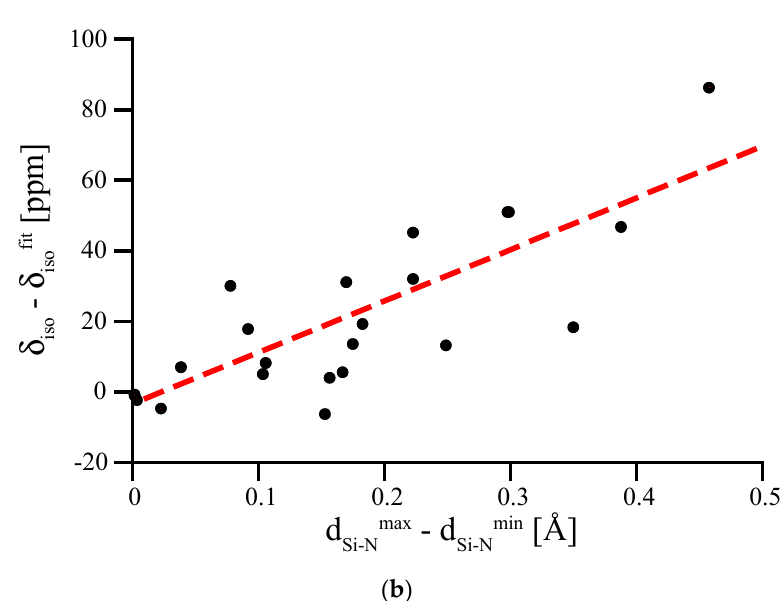
Figure 5. ( a ) 29 Si δ iso of Si [6] sites in hypothetical crystalline Si 3 N 4 plotted versus average Si-N bond length. The inserted line represents data for the Si [6] site in spinel-type γ -Si 3 N 4 , computed after scaling the structure. ( b ) Deviation of the computed 29 Si NMR δ iso for the distorted Si [6] sites plotted versus the difference between shortest and longest Si-N bond for that site. The dashed line represents a linear fit to the data.